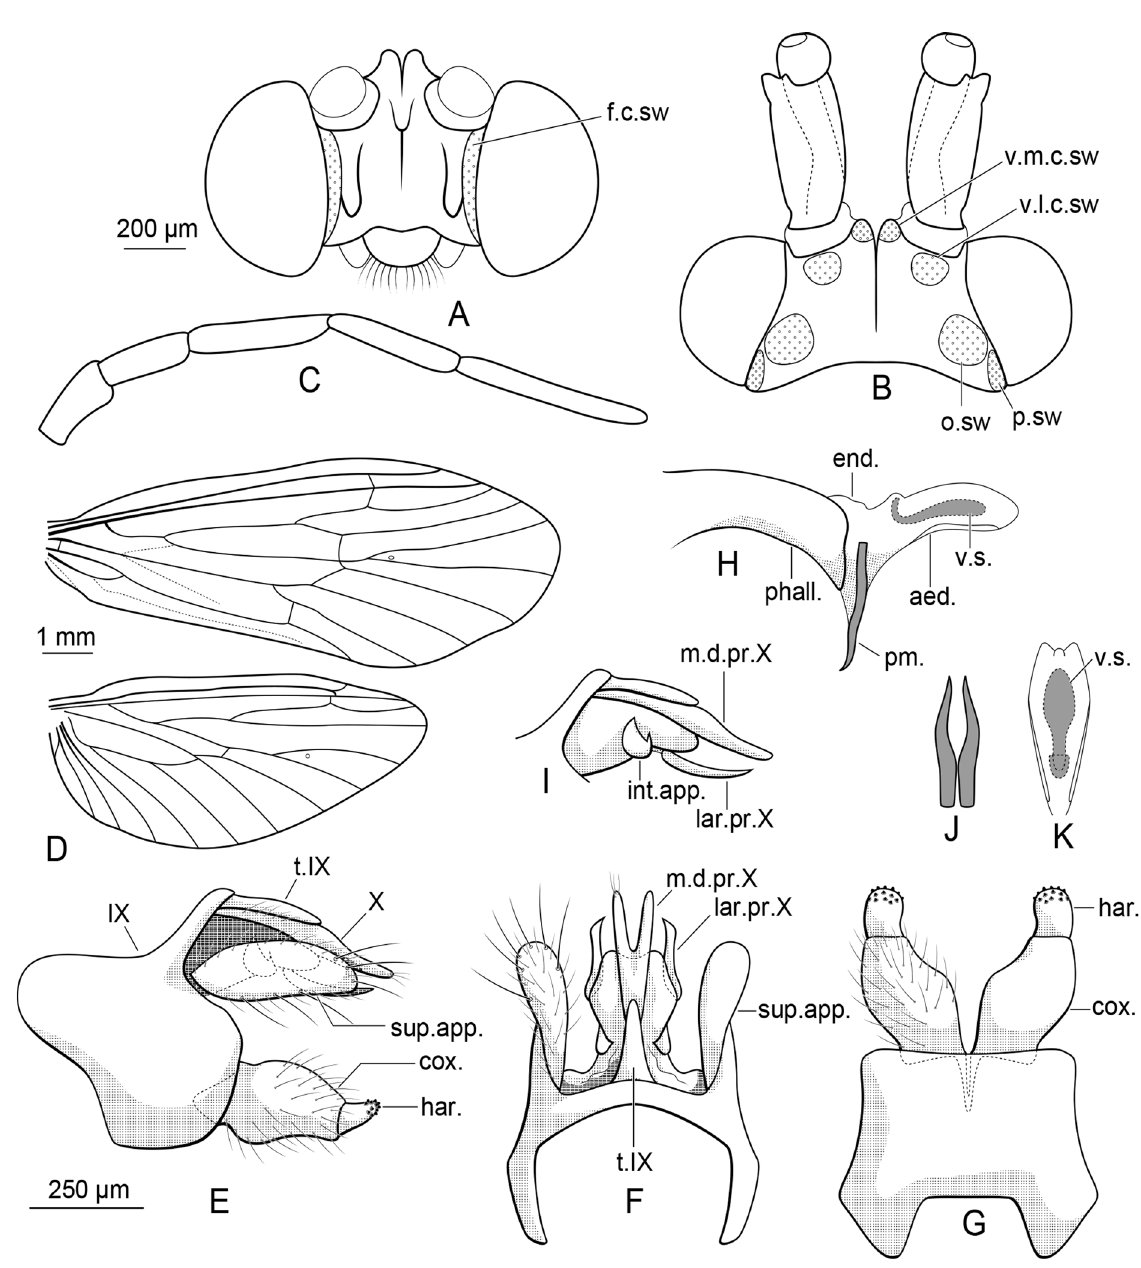
Fig. 2. Psilotreta furcata sp.nov. A . Head, anterior view. B . Head, dorsal view. C . Maxillary palp. D . Wing veins. E . Male genitalia, left lateral view. F . Male genitalia, dorsal view. G . Male genitalia, ventral view. H . Phallus, left lateral view. I . Segment X, left lateral view. J . Parameres, posterior view. K . Aedeagus, dorsal view. Scale bars: A–C = 200 µm; D = 1 mm; E–K = 250